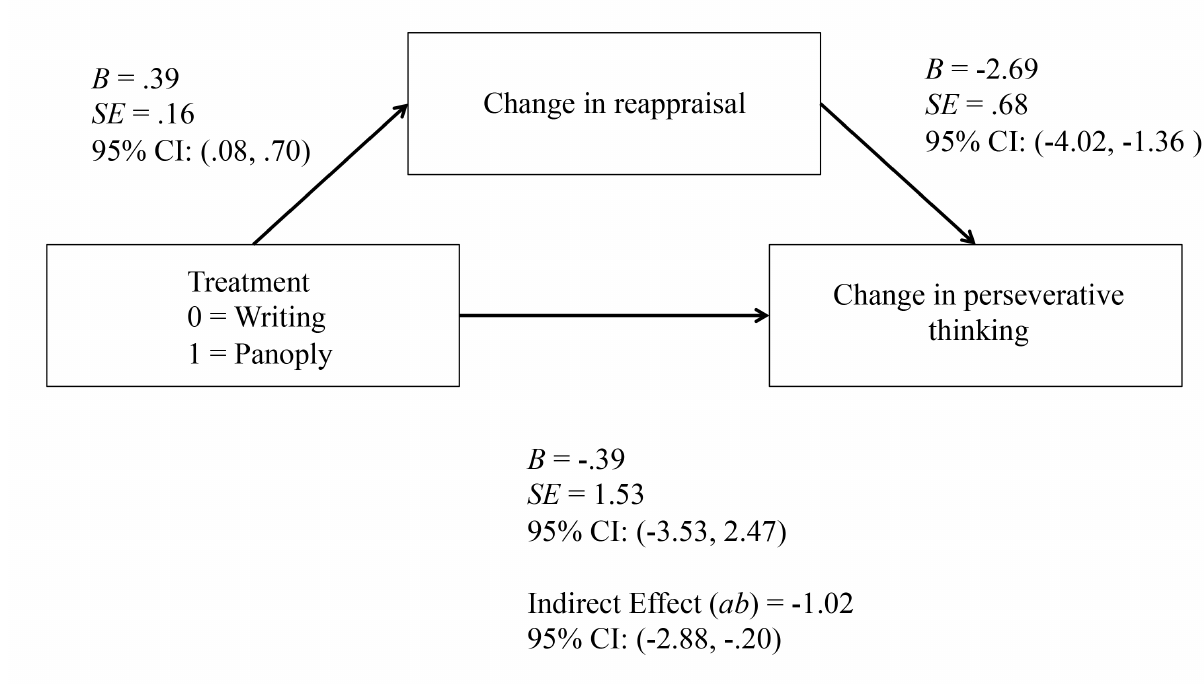
Figure 6. Mediation of change in reappraisal on change in perseverative